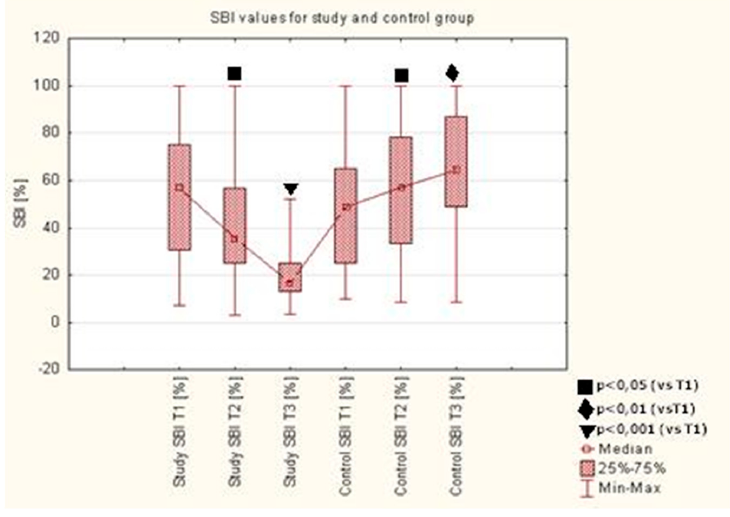
Figure 2. Modified sulcus bleeding index (mSBI) values in study and control groups.